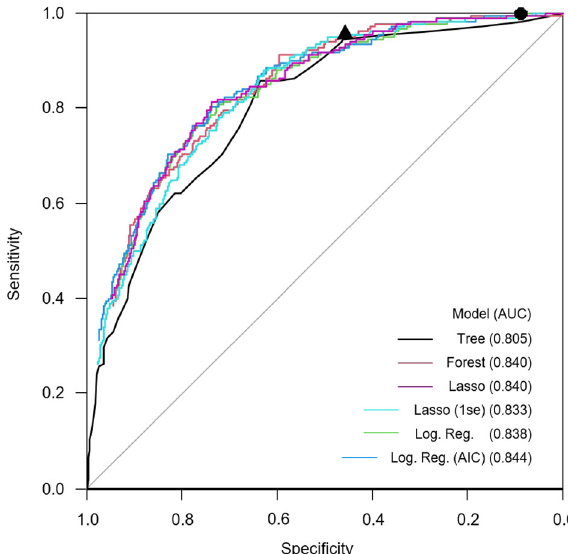
Fig. 2 ROC curves and AUC of the listed multivariable diagnostic models predicting a SARS-CoV-2-positive PCR test result. All questionnaire items (see Table 1), including age and sex, were offered to the algorithms. The sensitivity and speci fi city of speci fi c decision rules are added as individual points. Black circle ( ● ) represents at least one symptom #3 – 18 and/or contact with (suspected) infected patient (see Table 1). Black triangle ( ▴ ) represents at least one positive response to the four items: contact with infected person, anosmia/ageusia, fever, and sudden disease